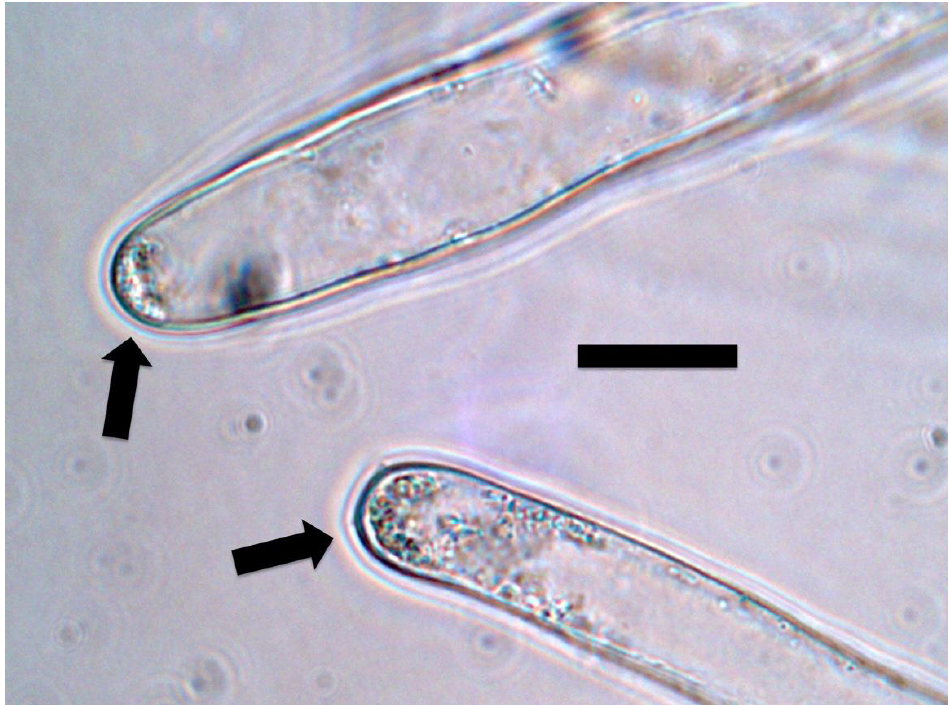
Figure 12. Intracellular bacteria (arrows) in oil seed rape root hair tips stained for nitrate (purple color) using 0.1% diphenylamine in 20% sulfuric acid. Nitrate is visualized around bacteria (bar = 15 µm).